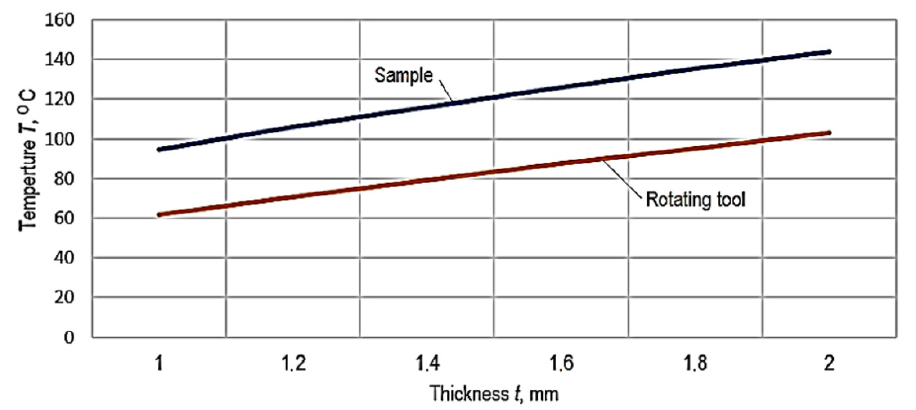
Figure 10. Different temperatures of the rotating forming tool and the sheet-type sample when using air as a working medium in the case of single-point incremental forming applied to polycarbonate sample ( f = 1500 mm/min, s d = 0.5 mm).